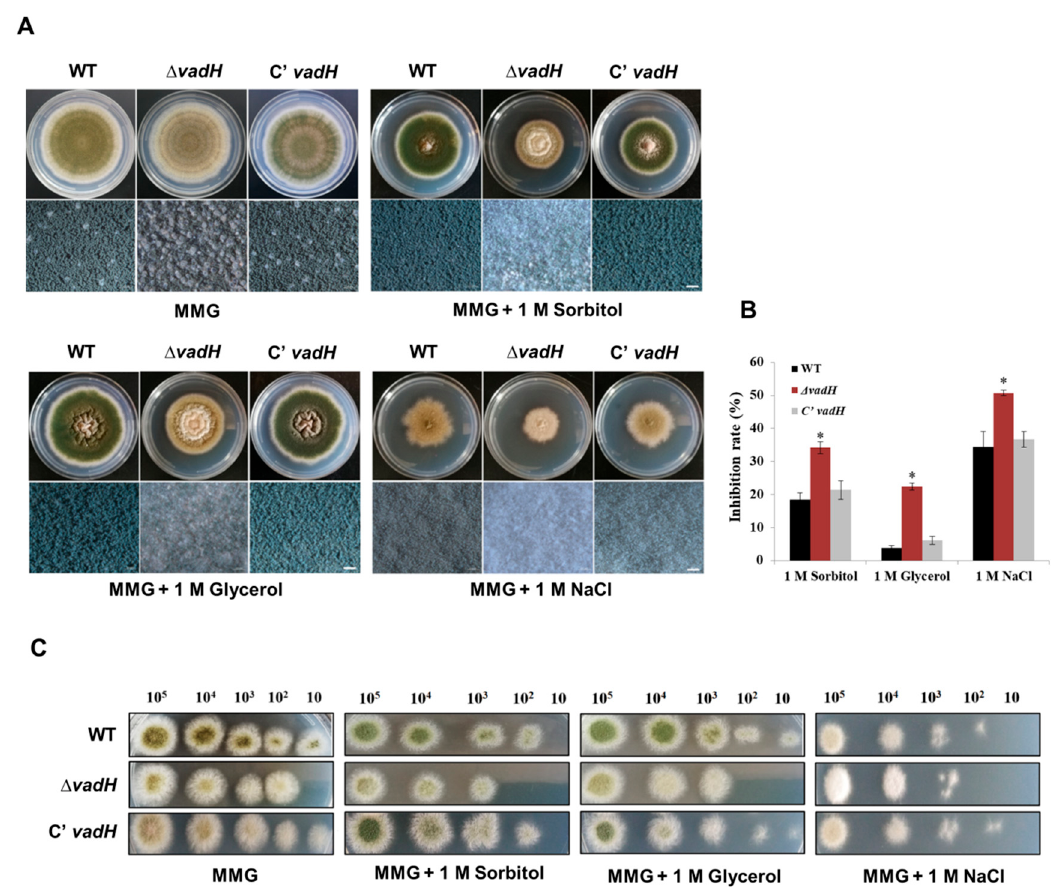
Figure 4. Effects of the hyperosmotic medium on the growth of WT, ∆ vadH and the complemented strain. ( A ) Comparison of the growth of strains on the MMG added with 1.0 M Sorbitol, 1.0 M Glycerol and 1.0 M NaCl and cultured at 37 °C for 7 days. The bottom panel shows close-up views of the colony in the top panel (Bar = 0.5 mm). ( B ) The inhibition rate of stress factors against WT, ∆ vadH and the complemented strain. The asterisks represent significant level (* p < 0.05). ( C ) The growth of serially diluted conidia on the MMG added with 1.0 M Sorbitol, 1.0 M Glycerol and 1.0 M NaCl, culturing at 37 °C for 2 days.